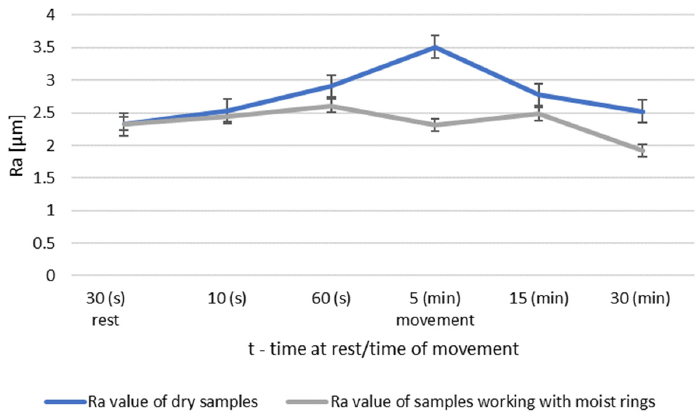
Figure 8. Comparison of Ra values of dry and wet ring samples for group II roughness.